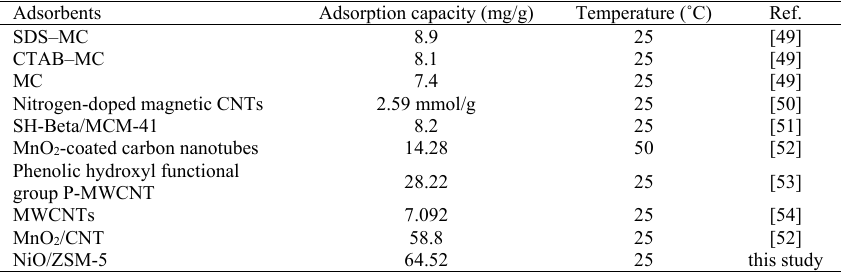
Table 3. Comparison of the mercury ion adsorption capacities of the various adsorbent.